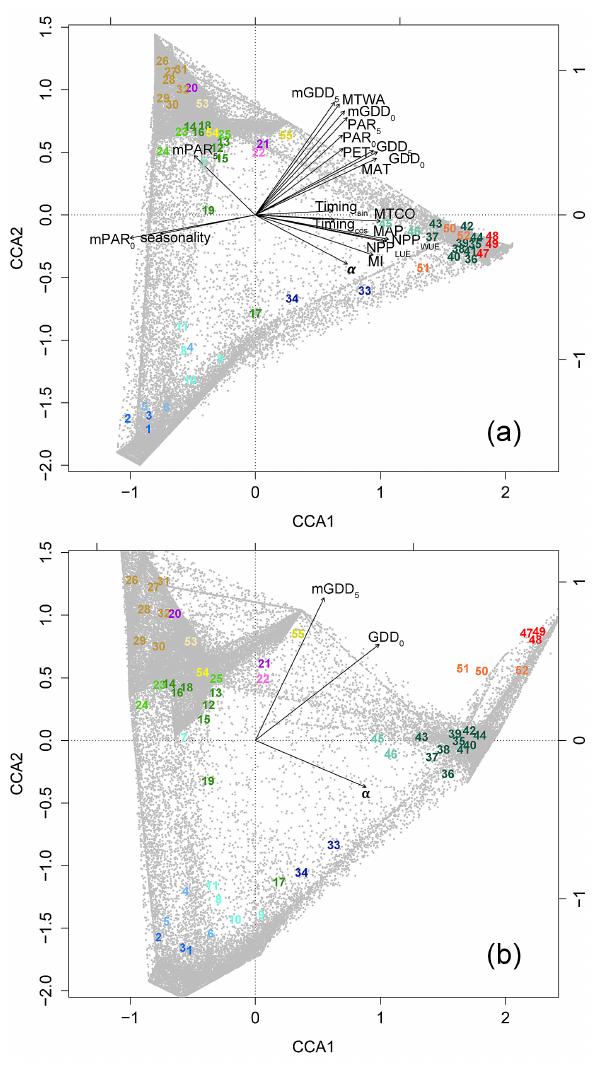
Fig. 4. Biplot of plant communities and environmental variables with all sample sites (grey dots) from canonical correspondence analysis using (a) 20 predictor variables, and (b) a subset of 3 pre- dictor variables selected using the Akaike information criterion. See text for the abbreviations of environmental variables, and Table 1 for the code numbers of plant communities. Vegetation classes are distinguished with colours as in the legend of Fig.